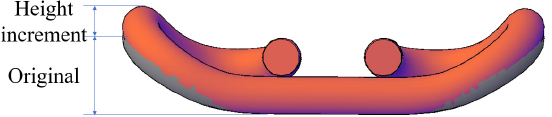
Figure 8. Perspective view of the change in the spring arm height.